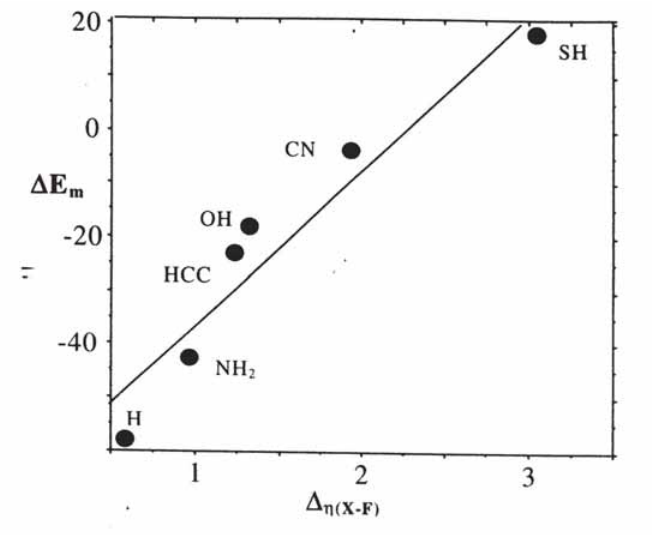
(in kcal mol -1 ) as a function of the group hardness m (Reprinted by permission by the American X-F